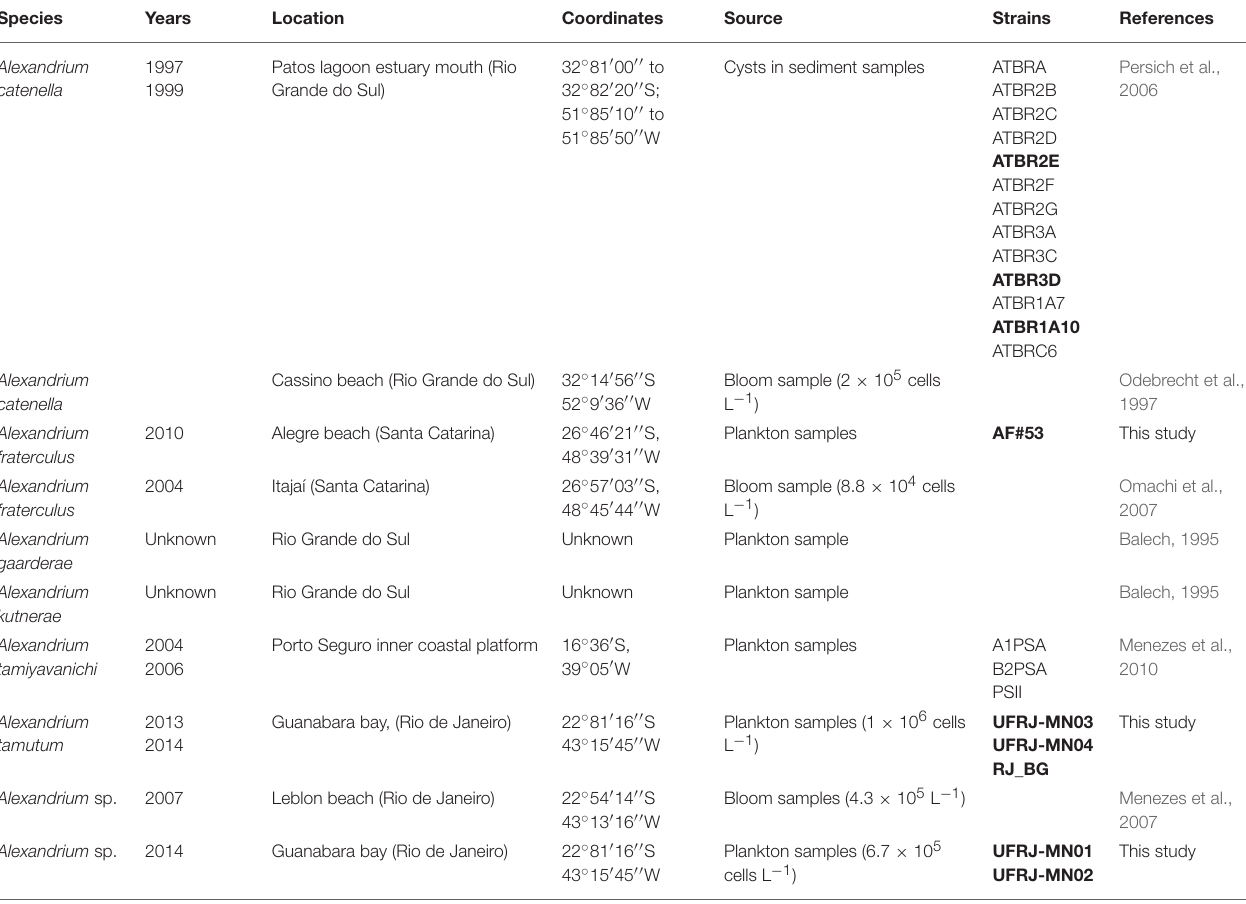
TABLE 1 | Records of Alexandrium species in Brazilian